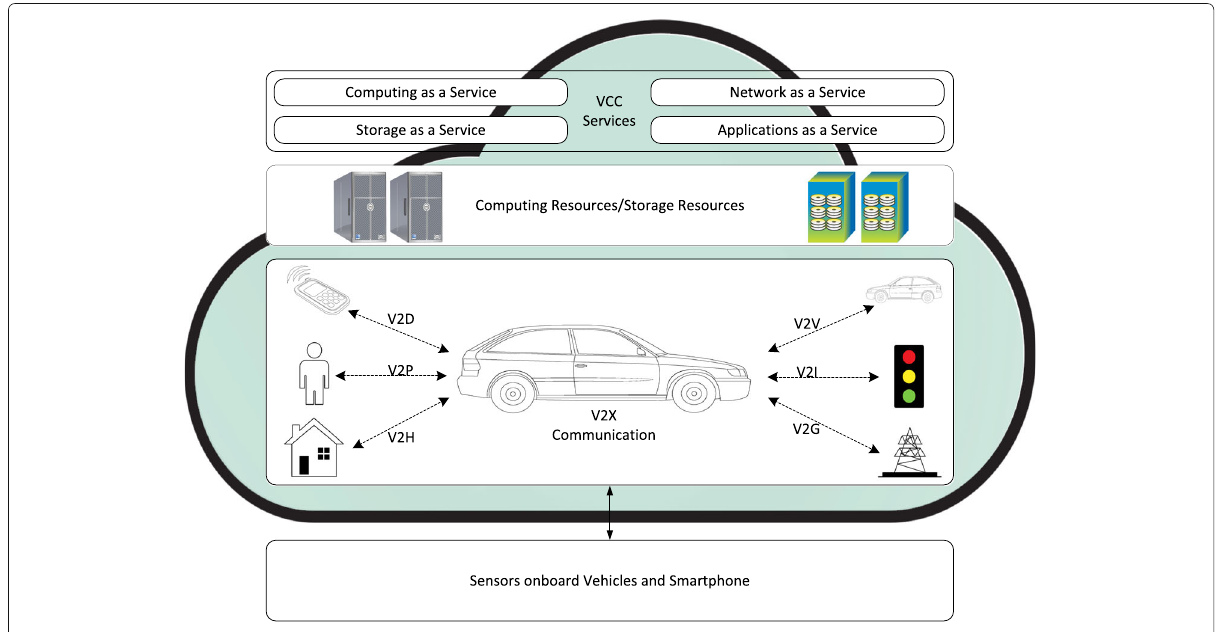
Fig. 1 V2X communication. Graphical representation of V2X